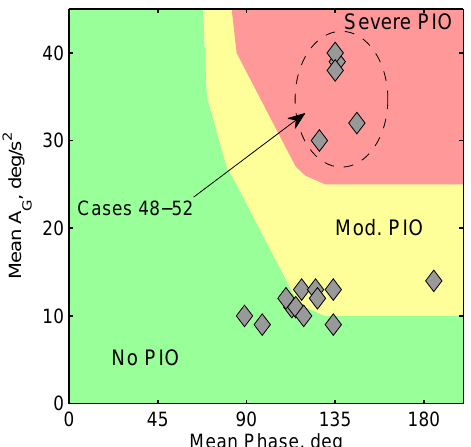
Figure 18. Average PAC parameters obtained during completion of manoeuvres, Day 1.